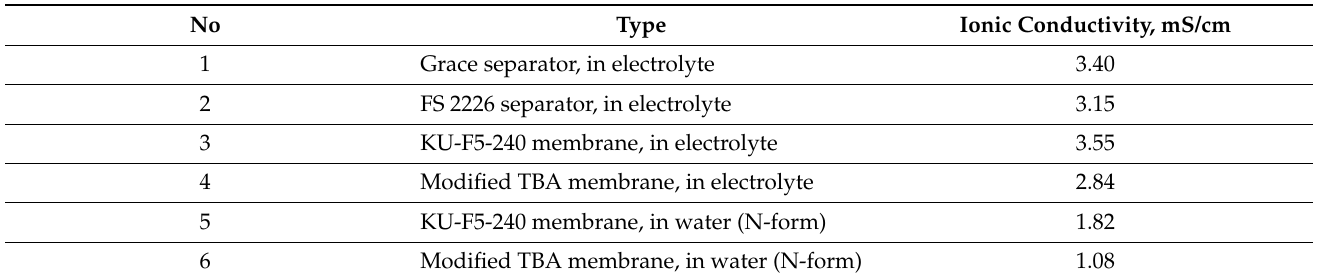
Table 2. Ionic conductivity of individual elements of the separator group measured by a two-electrode circuit (between graphite shims) at a pressure of 1.5 kg/cm 2 .